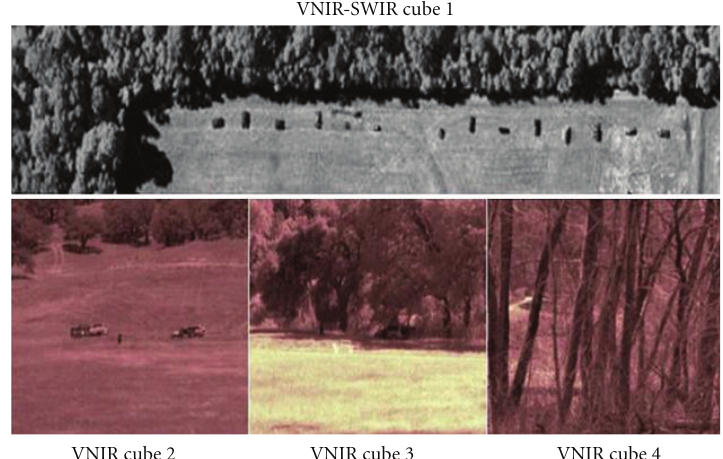
Figure 1: Examples of nadir looking imagery (Cube 1) and forward looking imagery (Cubes 2 through 4). An e ff ective anomaly detection algorithm suite would allow a machine to automatically detect the presence of manmade objects (targets), while suppressing the cluttered environment, using no prior information about what constitutes clutter background or target in the